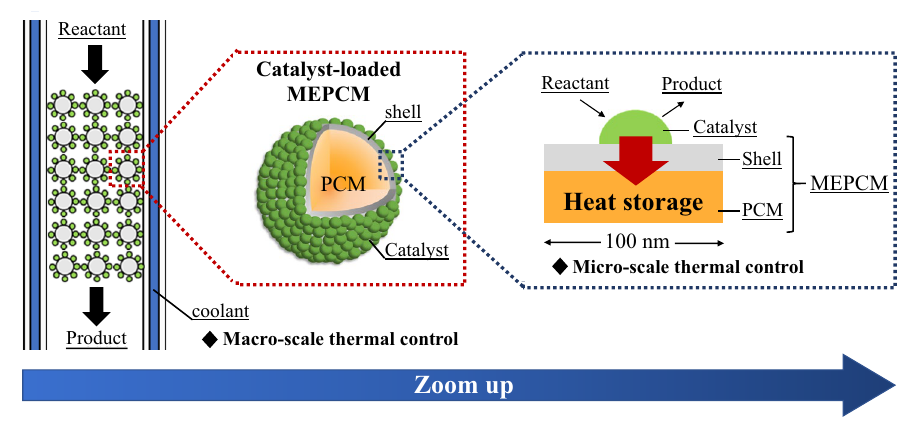
Figure 1. Schematic diagram of the catalyst-loaded MEPCM and the thermal control